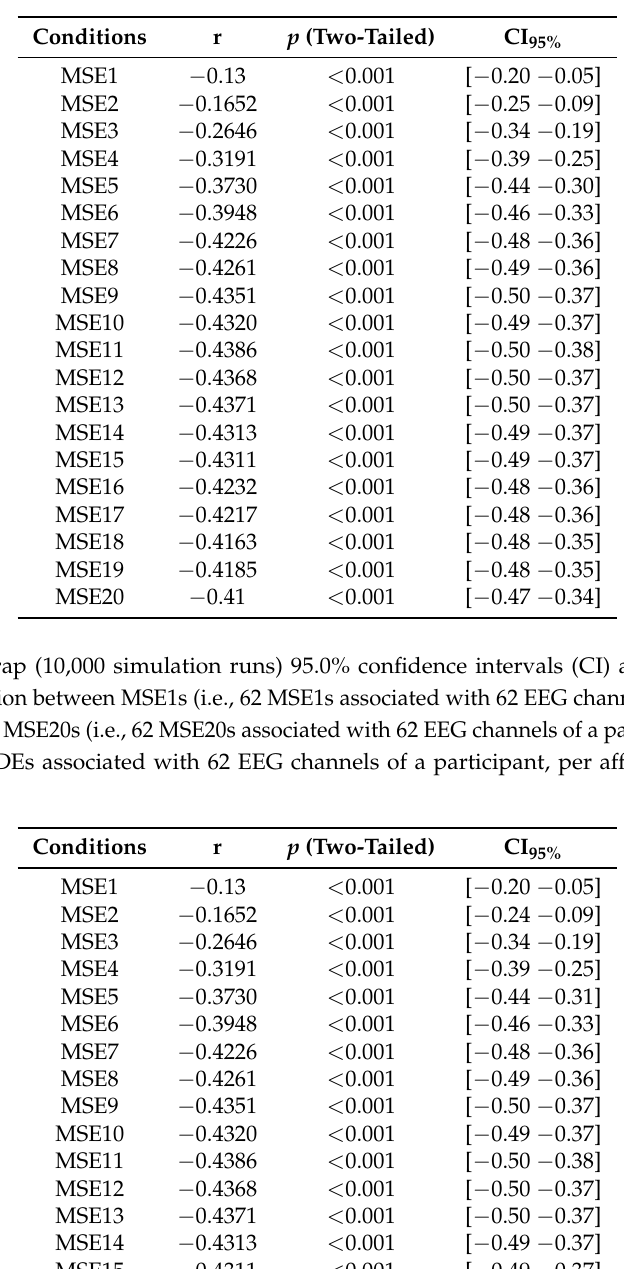
Table A8. Bootstrap (10,000 simulation runs) 95.0% confidence intervals (CI) associated with the Spearman correlation between MSE1s (i.e., 62 MSE1s associated with 62 EEG channels of a participant, per affect) through MSE20s (i.e., 62 MSE20s associated with 62 EEG channels of a participant, per affect) and DEs (i.e., 62 DEs associated with 62 EEG channels of a participant, per affect) in the neutral mental states.